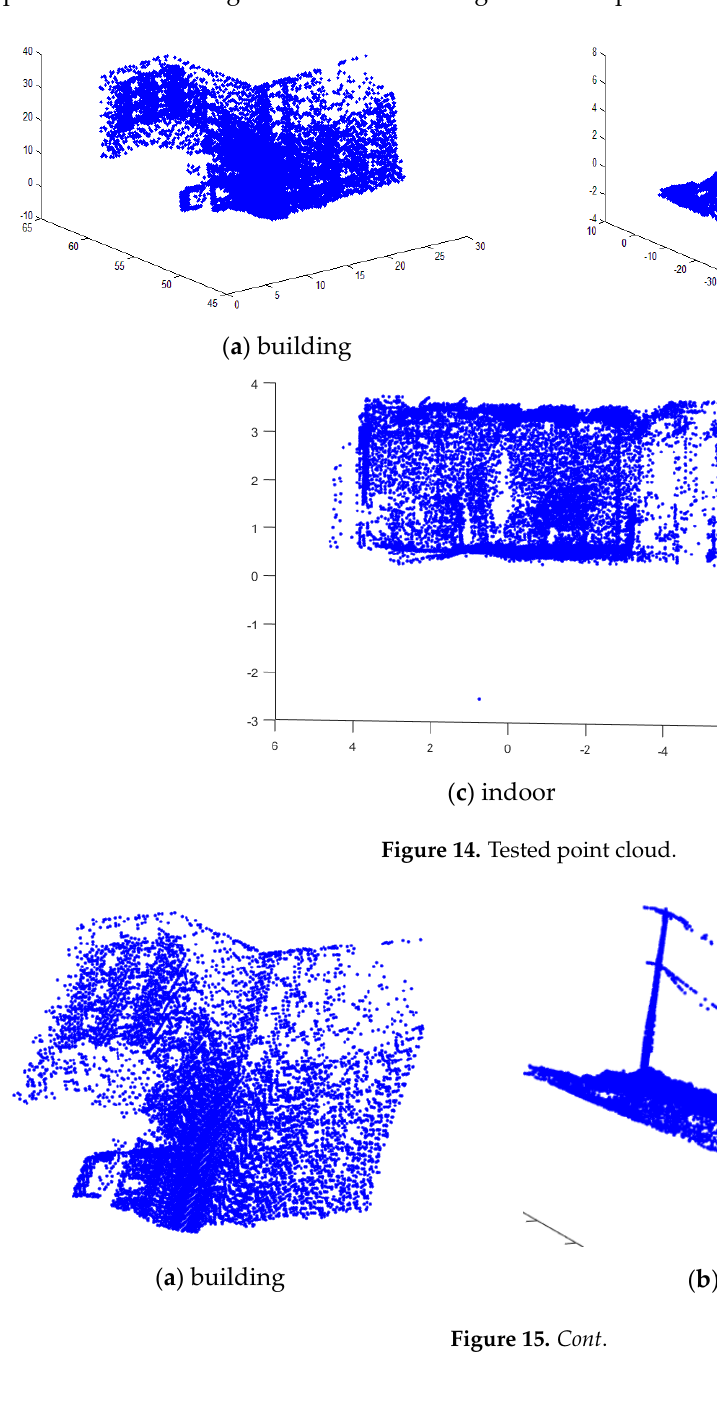
( c ) indoor scenes Figure 15. Point cloud registration results. 6. Conclusions The ICP algorithm is the mainstream algorithm in the process of accurate registration of 3D point cloud data. However, the algorithm has some problems. It requires a proper initial value and the approximate registration of two point clouds to prevent the algorithm from falling into into a local extremum, but in the actual point cloud matching process, it is difficult to ensure compliance with this requirement. In this paper, we proposed an ICP algorithm based on point cloud features (GF-ICP). The method uses the geometrical features of the point cloud to be registered, such as curvature, surface normal and point cloud density, to search for the correspondence relationships between two point clouds and introduces the geometric features into the error function to prevent the ICP algorithm from falling into a local extremum and achieve accurate registration of two point